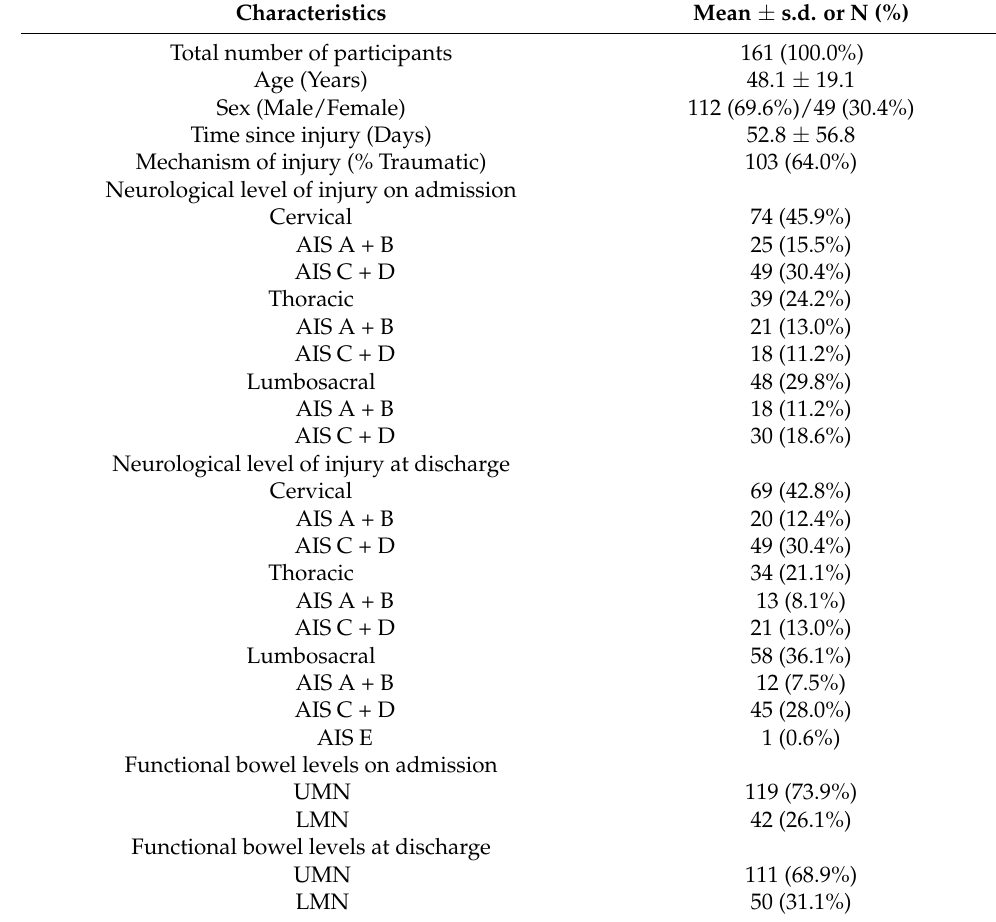
Table 1. Demographic characteristics of participants.